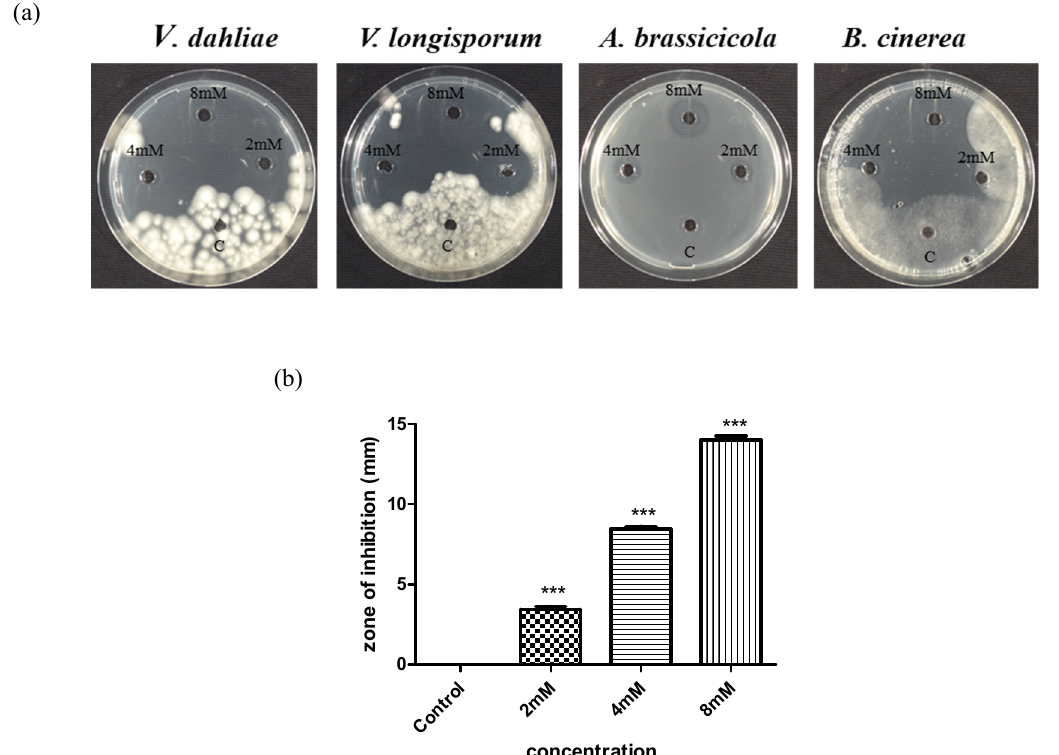
Figure 3. Plate inhibition zone assay showing the antifungal activity of allicin against model fungi. Fungal cultures were incorporated into warm agar (50 °C) and poured into a Petri dish. ( a ) Representative pictures for fungi ( V. dahliae , V. longisporum , A. brassicicola and B. cinerea ). The lower well contained 20 μ L of sterile water (Control). ( b ) The diameter of inhibition zone was measured for the hole containing 20 μ L of 2, 4 and 8 mM solution of allicin against A . brassicicola . Error bars show standard deviation about the mean, n = 9.